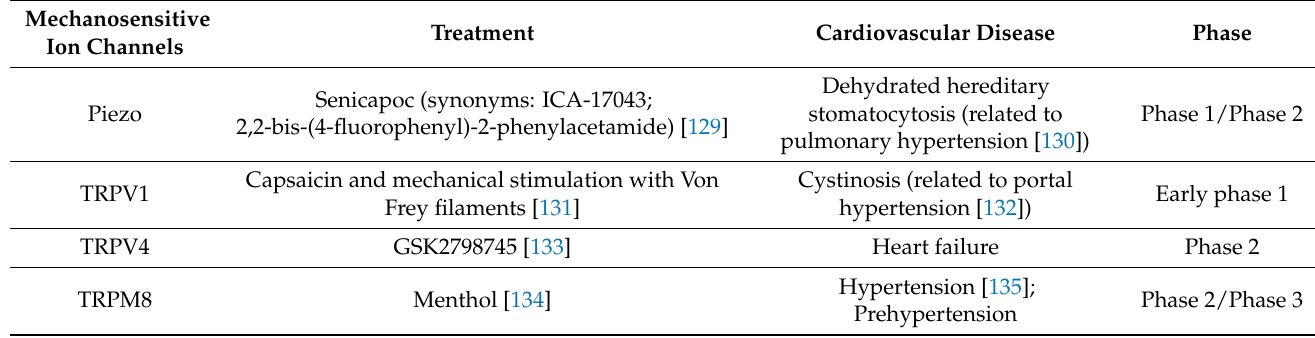
Table 2. Current clinical trials for drug specifically targeting these mechanosensitive ion channels are run in the cardiovas- cular system, according to the ClinicalTrials.gov website (available online and accessed on 12 August 2021).